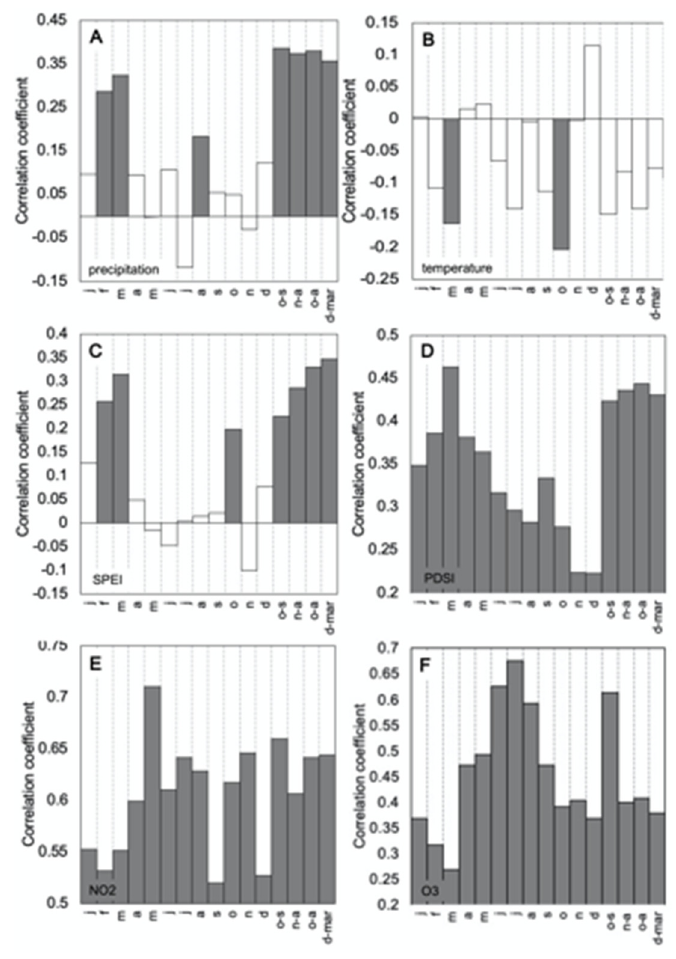
Figure 4. Relationships between the Crestline tree ring chronology and selected months and seasons